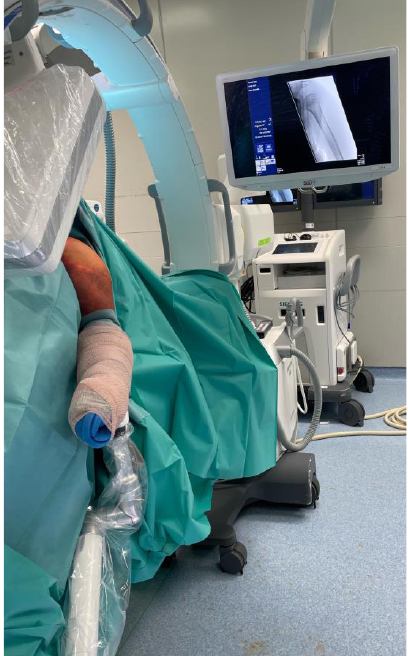
Figure 1. Patient positioning.